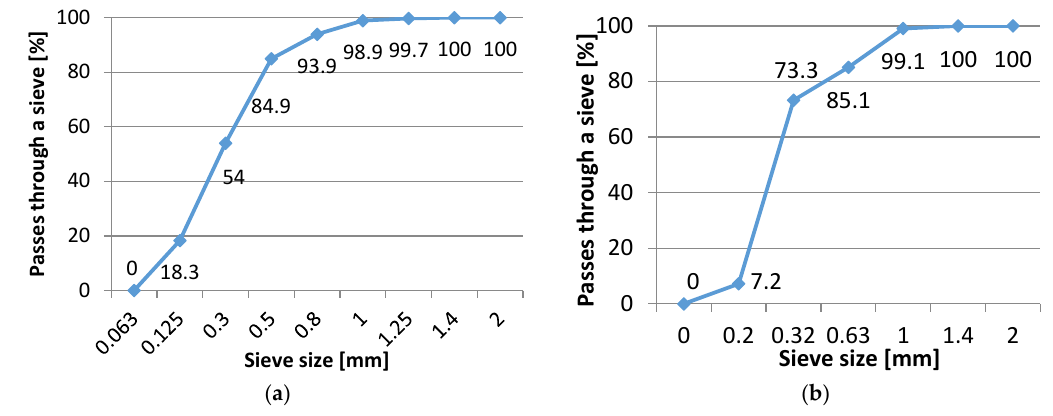
Figure 3. Sieve size of: ( a ) cement used to make the substrate, ( b ) fine aggregate used to make the substrate made of cement mortar.